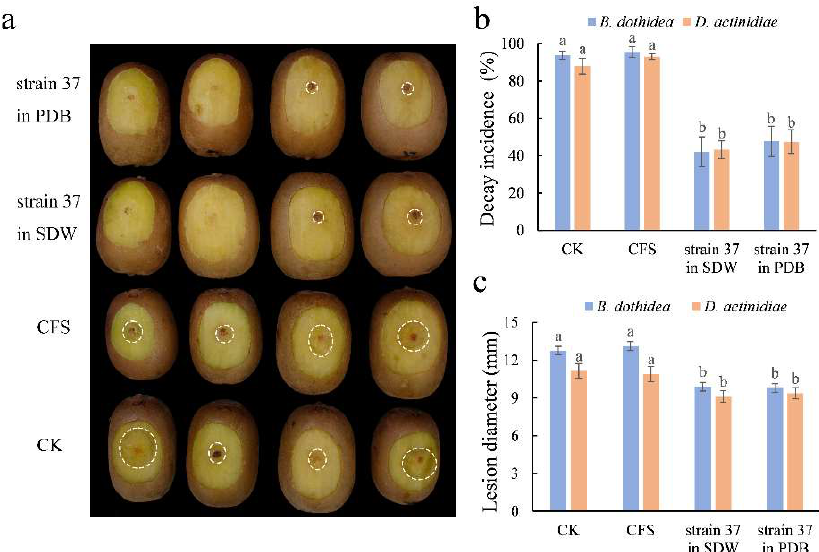
Figure 5. Effect of different treatments of M. guilliermondii 37 on kiwifruit soft rot caused by B. dothidea and D. actinidiae . Symptoms caused by B. dothidea ( a ); decay incidence ( b ); and lesion diameter ( c ) were evaluated after 5 days of treatment at 25 °C, RH 90%. The data is represented as mean ± SE. The letters above the columns show statistically significant differences ( p < 0.05) as assessed with Duncan’s multiple range test.